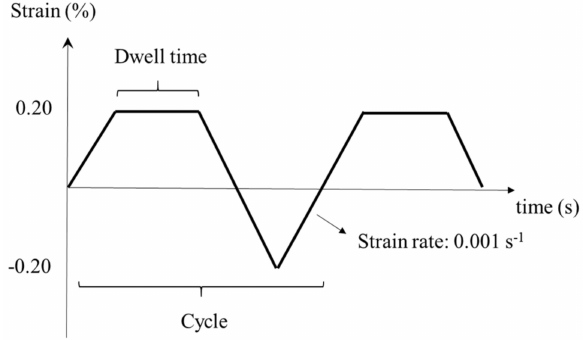
Figure 3. Schematic representation of creep-fatigue test.